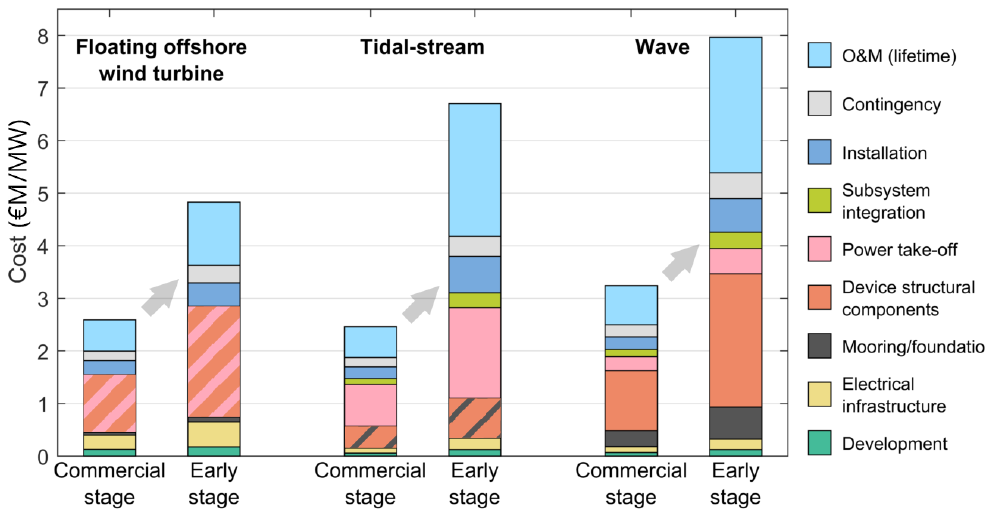
Figure 8. Commercial- and early-stage costs for the central LR scenario for each of the three offshore renewable technologies. Note that some subsystems are combined, shown by hatched bars. Table 9. Commercial stage target costs per MW for floating offshore wind, tidal stream, and wave energy.